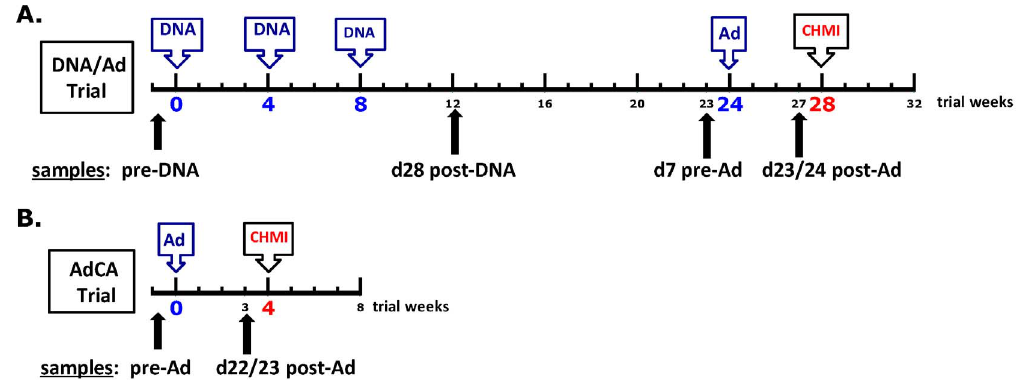
Figure 1. DNA/Ad Trial design. DNA/Ad Trial: Healthy, malaria-naı¨ve adult research subjects received three doses of two DNA plasmids (mixture of 1 mg CSP and 1 mg AMA1, 2 mg total dose, in 2 ml phosphate buffered saline) in two divided doses of 1 ml into each deltoid muscle by needleless jet injection, followed by one dose of two adenovectors (mixture of 1 6 10 10 particle units CSP and 1 6 10 10 particle units of AMA1, 2 6 10 10 particle units total dose, in 1 ml final formulation buffer) into one deltoid muscle by needle and syringe. Both Ad5 seropositive and seronegative study subjects were enrolled. AdCA Trial: Malaria-naı¨ve adult research subjects received one dose of two adenovectors (formulated identically as in DNA/ Ad) into one deltoid muscle by needle and syringe. Only Ad5 seronegative study subjects (neutralizing antibody titer , 500, NVITAL assay) were enrolled. CHMI = controlled human malaria infection, administered via the bites of five laboratory-reared P. falciparum -infected Anopheles stephensi